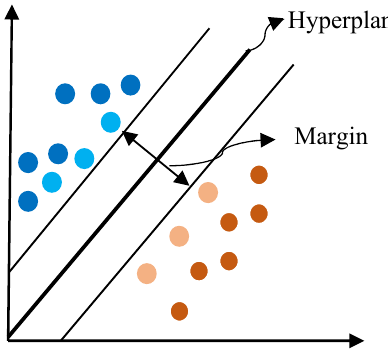
Figure A2. The introduction to Support Vector Machines.